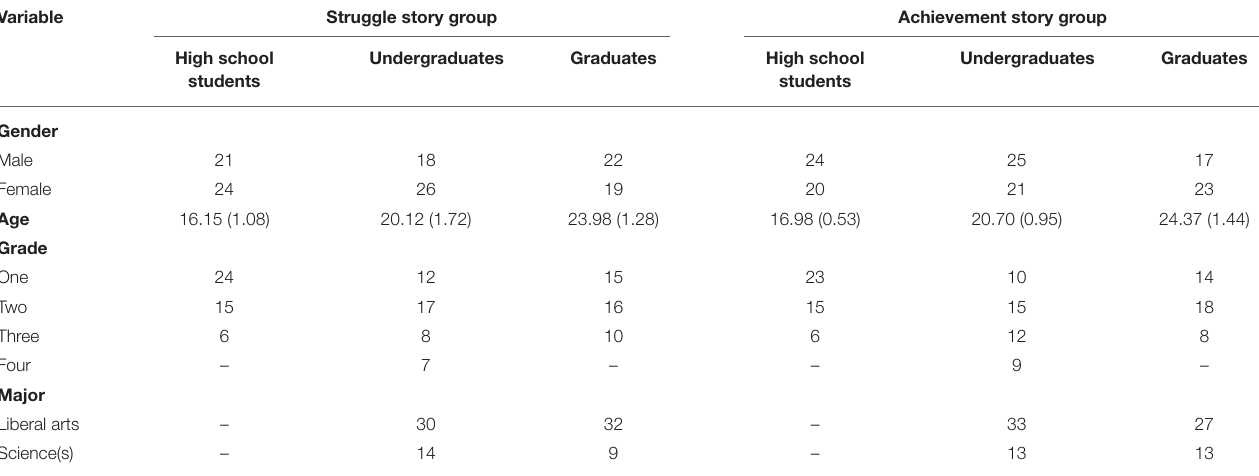
TABLE 1 | The number, gender, age, grade, and major of each group.